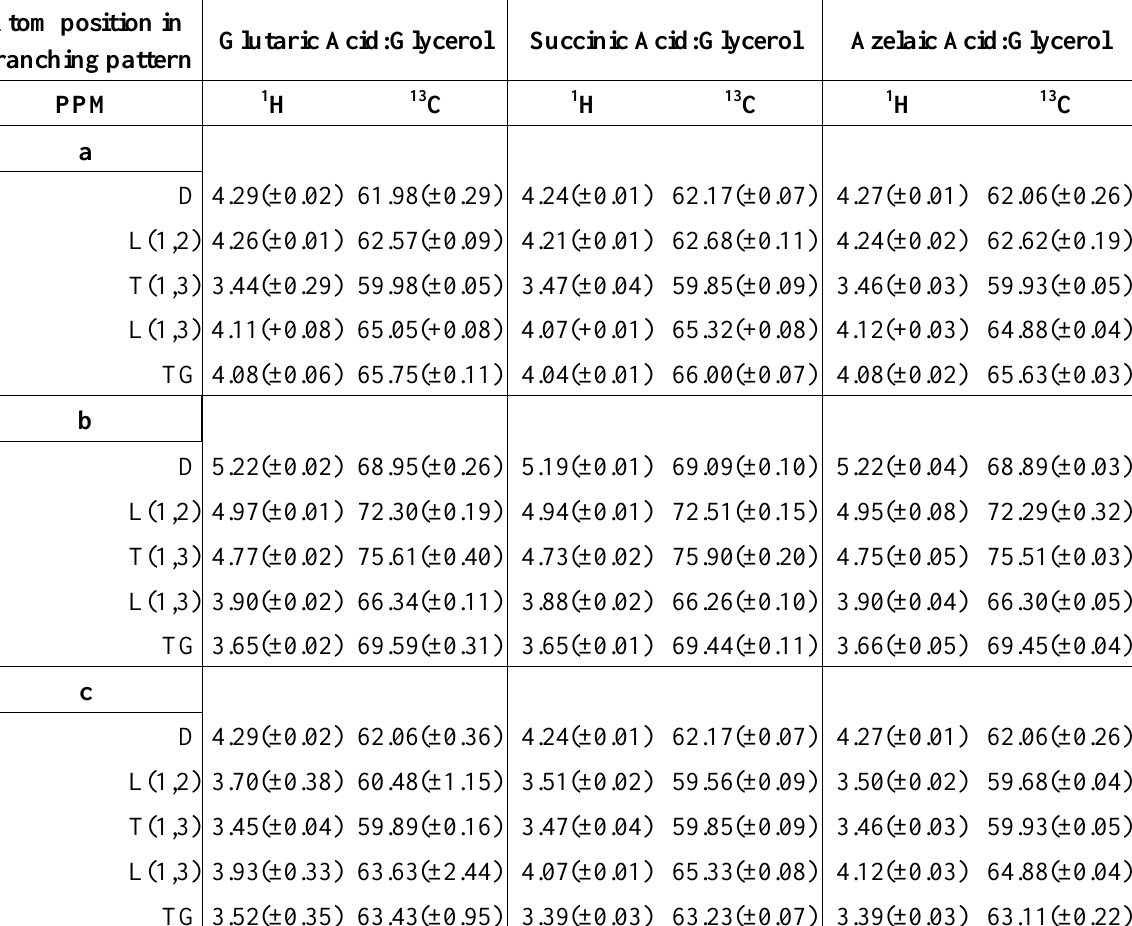
Table 1. Averaged NMR resonance assignments (with standard deviations) for diacid acid-glycerol polymer branching patterns as shown in Figure